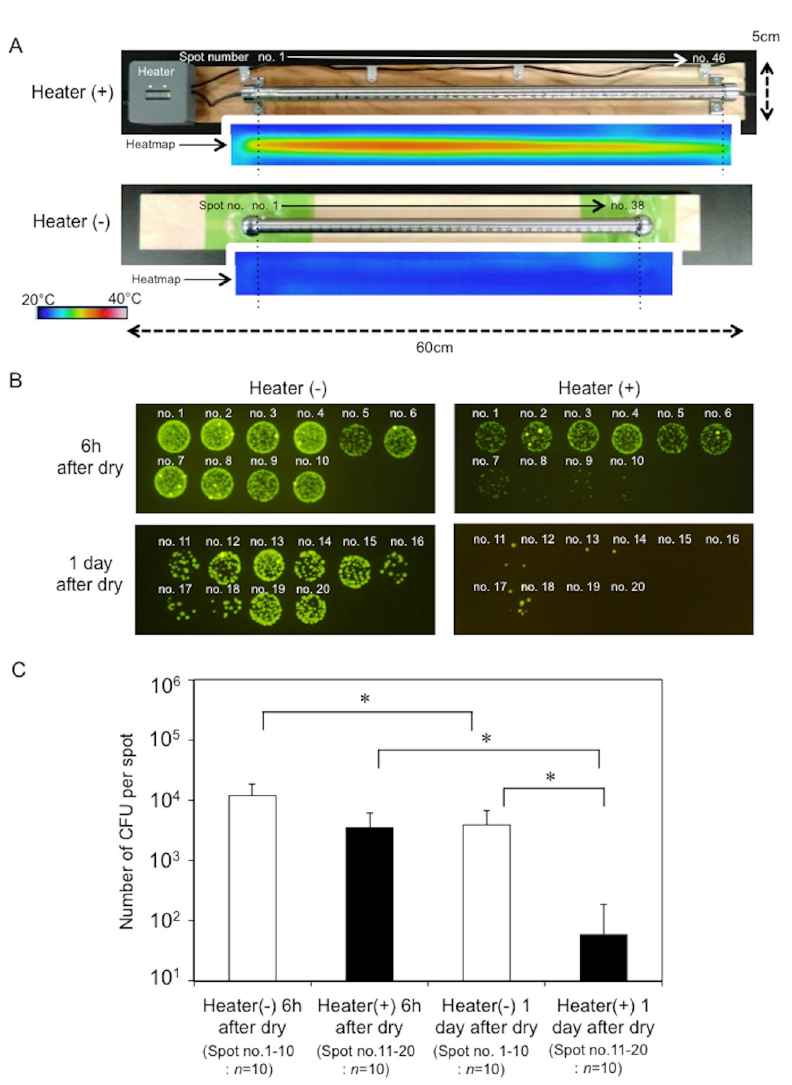
Fig 5. Handrail device warmed to human body core temperature prohibited the prolonged survival of GFP- expressing E . coli on a stainless steel surface. A . Heatmaps of the handrail device with or without a heater. The heatmaps were constructed using a high-resolution infrared sensor (InfReC R300) installed with appropriate software (InfReC Analyzer NS9500). B . Representative images showing decreasing GFP-signals for the bacteria collected from the stainless steel surface warmed by the heater. Numbers show the sampling positions on the pipe. Heater (-), handrail device without heater. Heater (+), handrail device with heater. C . Comparison of the bacterial CFU numbers on the stainless steel device with and without the heater. Black and white bars show the CFU values for the device with and without the heater. � , p < 0.05 between the